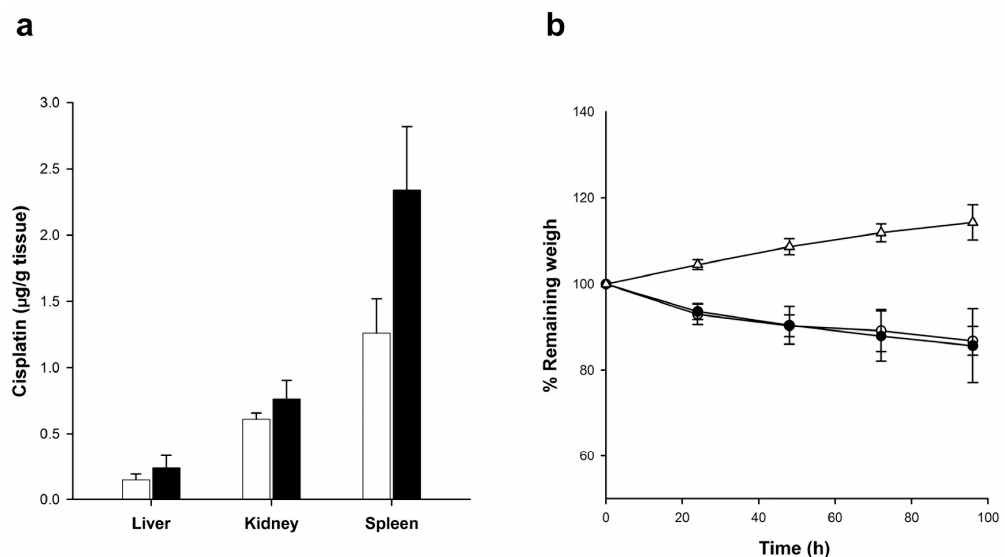
Figure 7. ( a ) Cisplatin accumulation in tissues 96 h after administration of cisplatin-loaded liposomes (Cis-Ls, white bars) or cisplatin-loaded magnetic liposomes (Cis-MLs, black bars); in both cases, the injected dose corresponds to 6 mg/kg cisplatin and 2 mg/kg iron; ( b ) Remaining weight versus time following the administration of Cis-Ls (white dots), Cis-MLs (black dots), and control group (animals without any treatment, open triangles). The animals were weighed before the liposome injection and every 24 h post-administration. Values are expressed as the mean ± SEM ( n = 5–6).